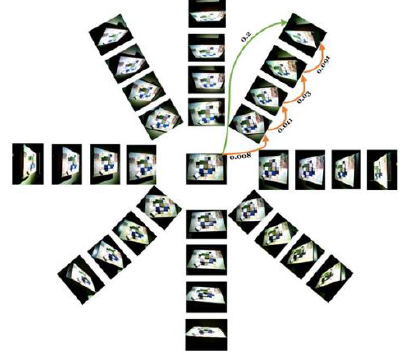
Figure 1 . An illustration of multiview 33 images with an example of a direct path (green line) and the shortest path (indicated with orange lines) between two